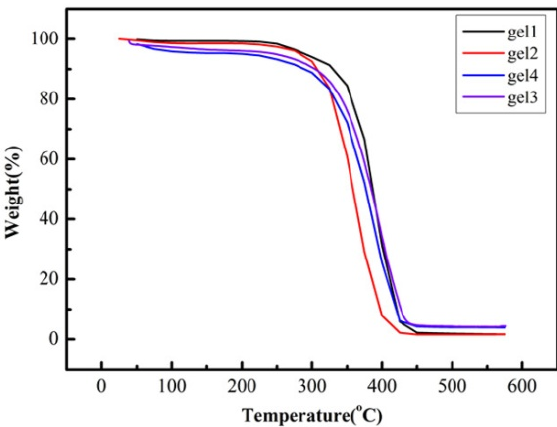
Figure 9. Thermogravimetric curve of gel1, gel2, gel3, and gel4.